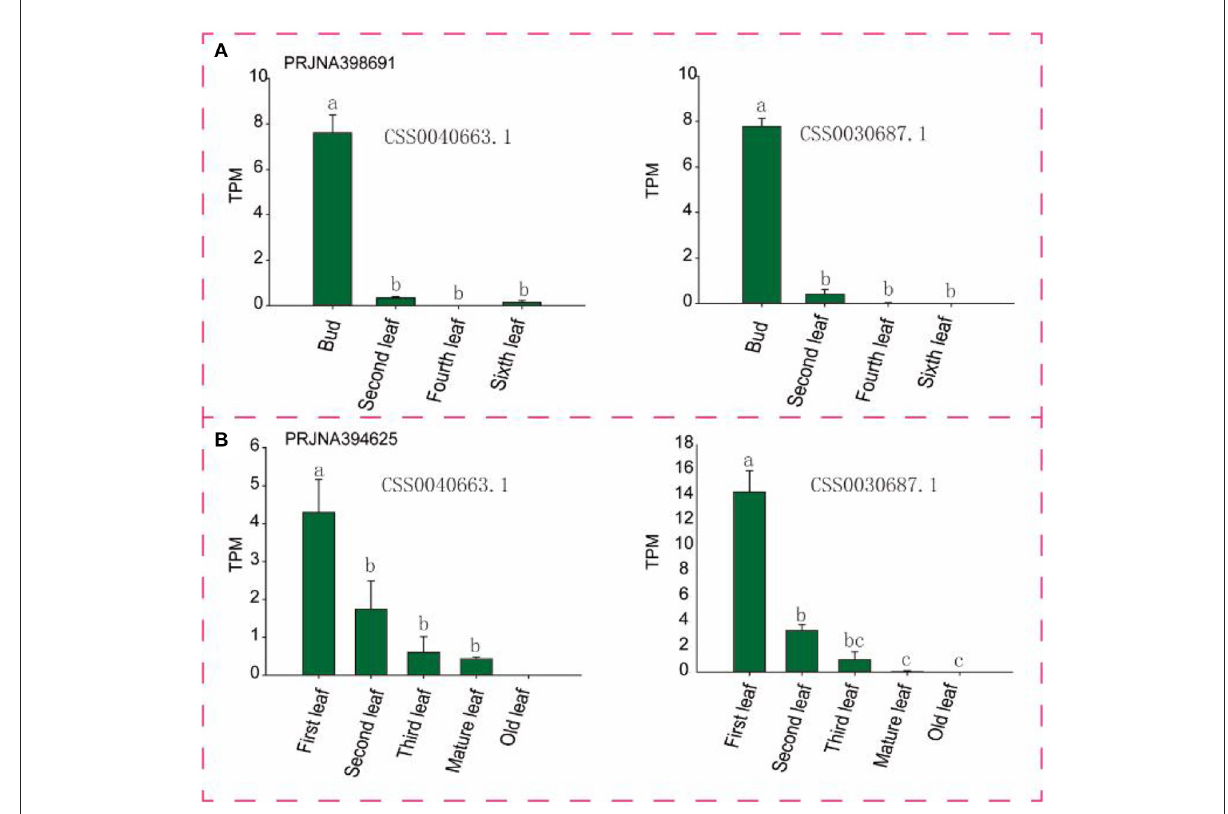
FIGURE6 Expression levels of two candidate genes in different transcriptome and different tissues. (A,B) Represent different transcriptome data sources, respectively. TPM, Transcripts Per Kilobase of exon model per Million mapped reads. Different letters indicate significant differences (P <